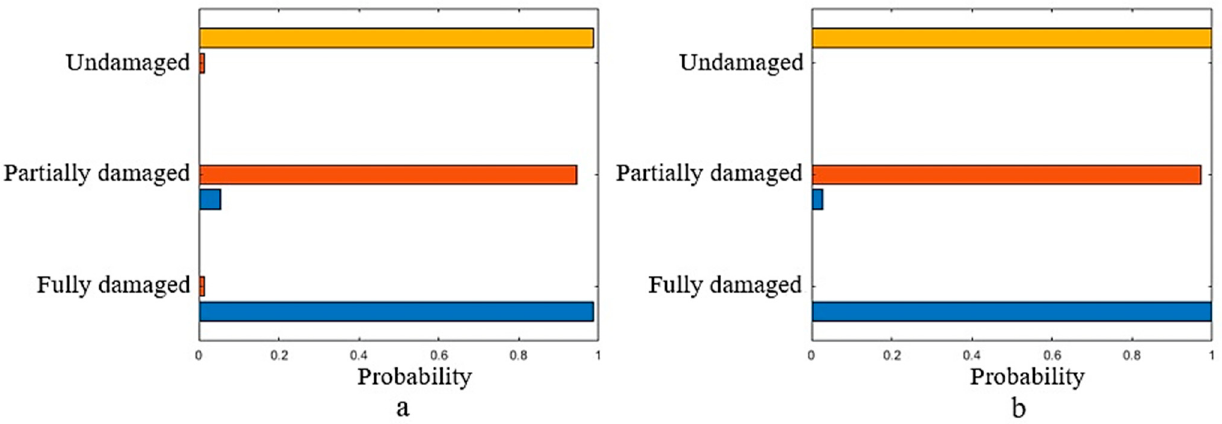
Figure 6. Illustration of performance of the two classifiers presented based on confusion matrix. ( a ) Vgg16 and ( b ) ResNet50.